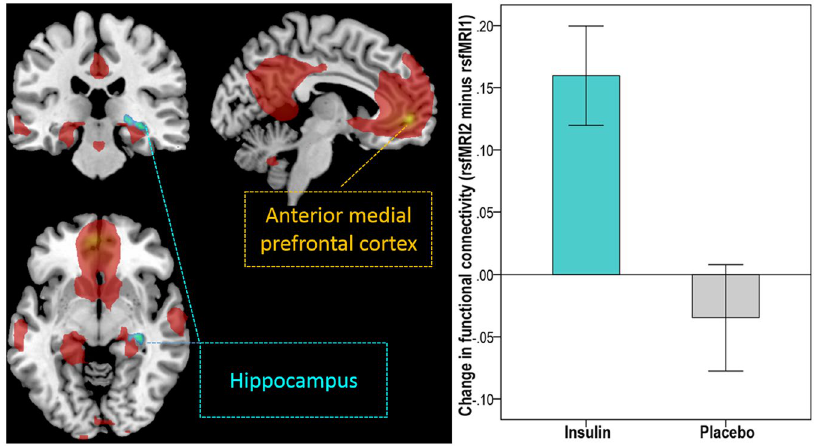
Figure 2. Intranasal insulin increased functional connectivity between the anterior medial prefrontal cortex (PFC) of the default-mode network (DMN) and the hippocampus in lean, overweight and obese participants. Group-averaged DMN of lean and overweight/obese participants under baseline condition (rs fMRI1 ) for the anterior medial PFC seed region is displayed in red (p < 0.05, FWE whole-brain corrected). Cyan- color coded region reveals voxels within the right hippocampus showing a significant change in functional connectivity within the DMN based on the anterior medial PFC seed region after intranasal insulin compared to placebo (p FWE < 0.05 small volume corrected). Bar plot on right shows the change in functional connectivity after intranasal insulin and placebo (rs fMRI2 minus rs fMRI1 ) between the anterior medial PFC and the hippocampus in lean, overweight and obese participants (i.e. the extracted differential correlation coefficients of the right